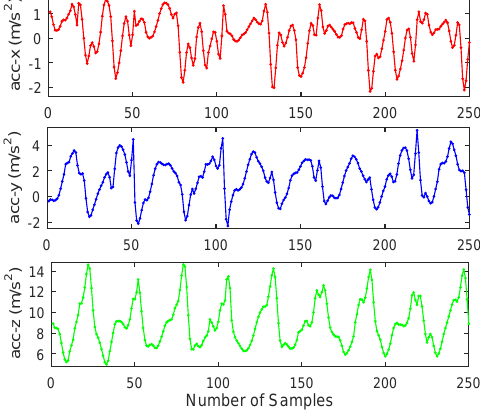
Figure 2: Repetitiveness and periodicity of users’ walking (The user walks with the phone in the hand without